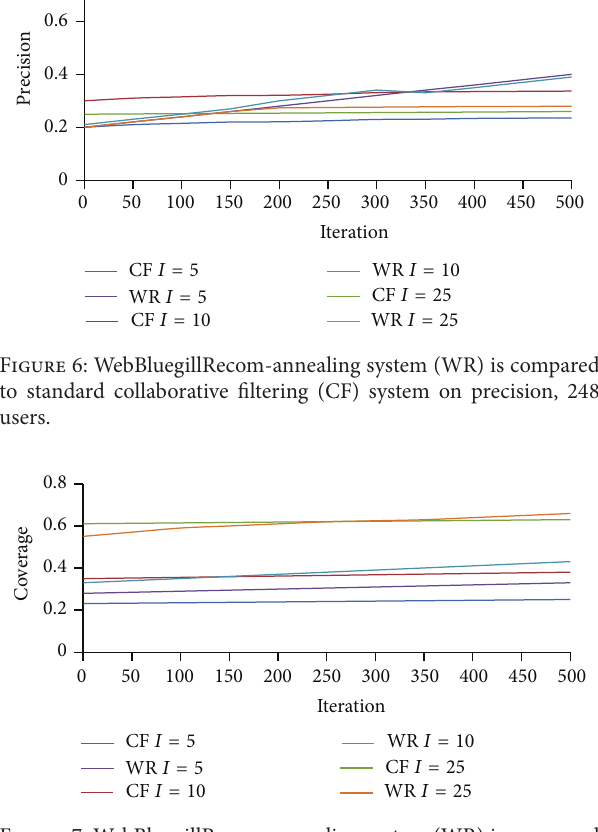
Figure 9: WebBluegillRecom-annealing system (WR) is compared to standard collaborative filtering (CF) system on precision, 𝐼 = 5 , 248